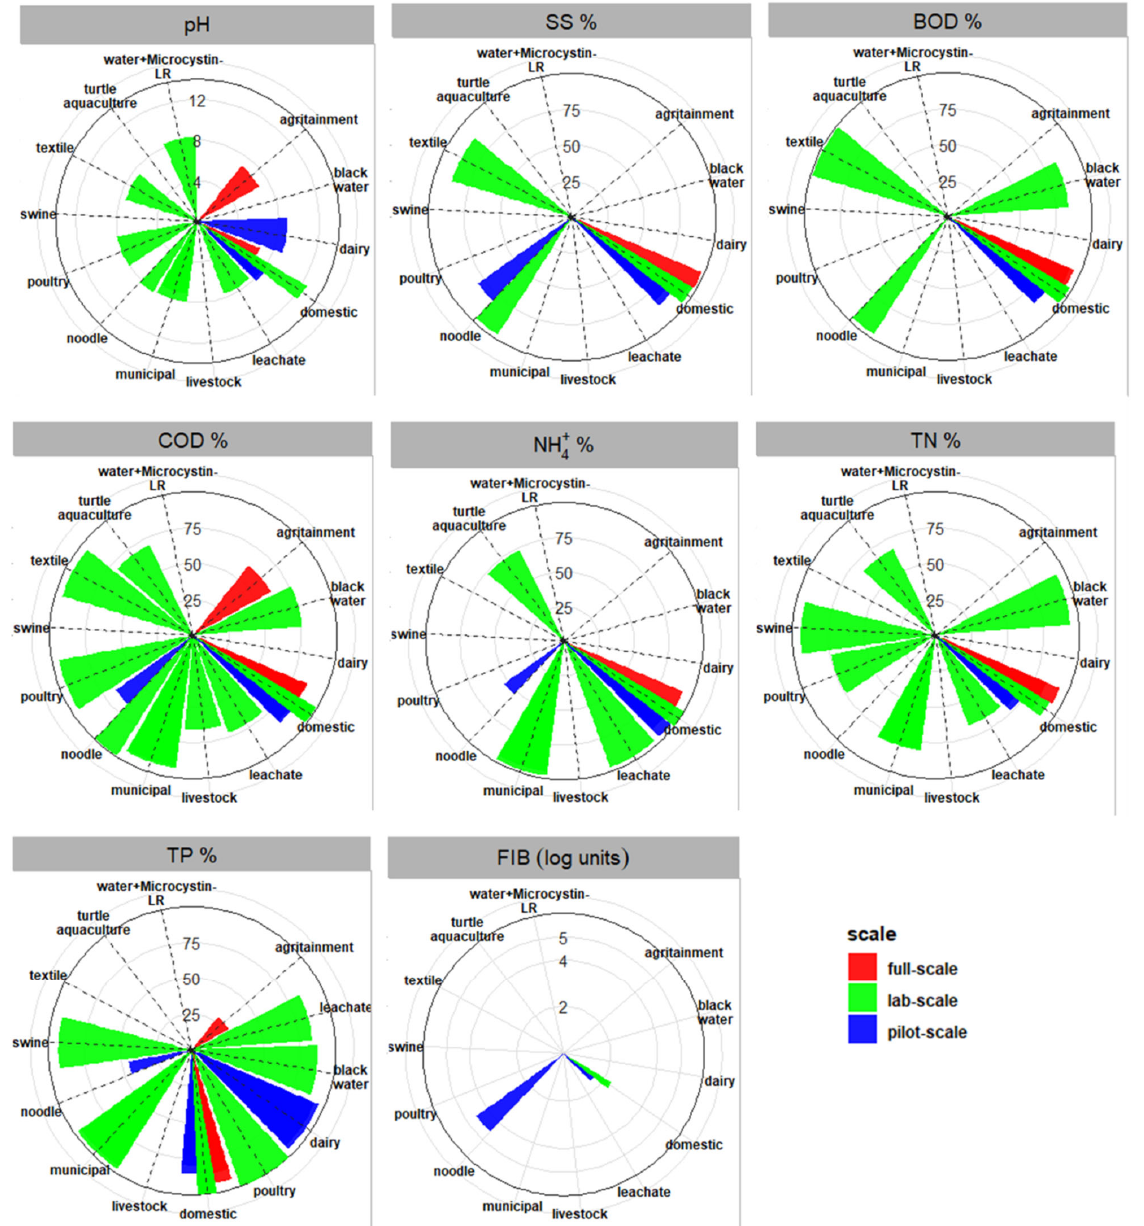
Figure 9. Performance of single ‐ stage MSL systems while treating a variety of wastewaters at dif ‐ ferent configurations; scale inside plots indicates the removal efficiency.